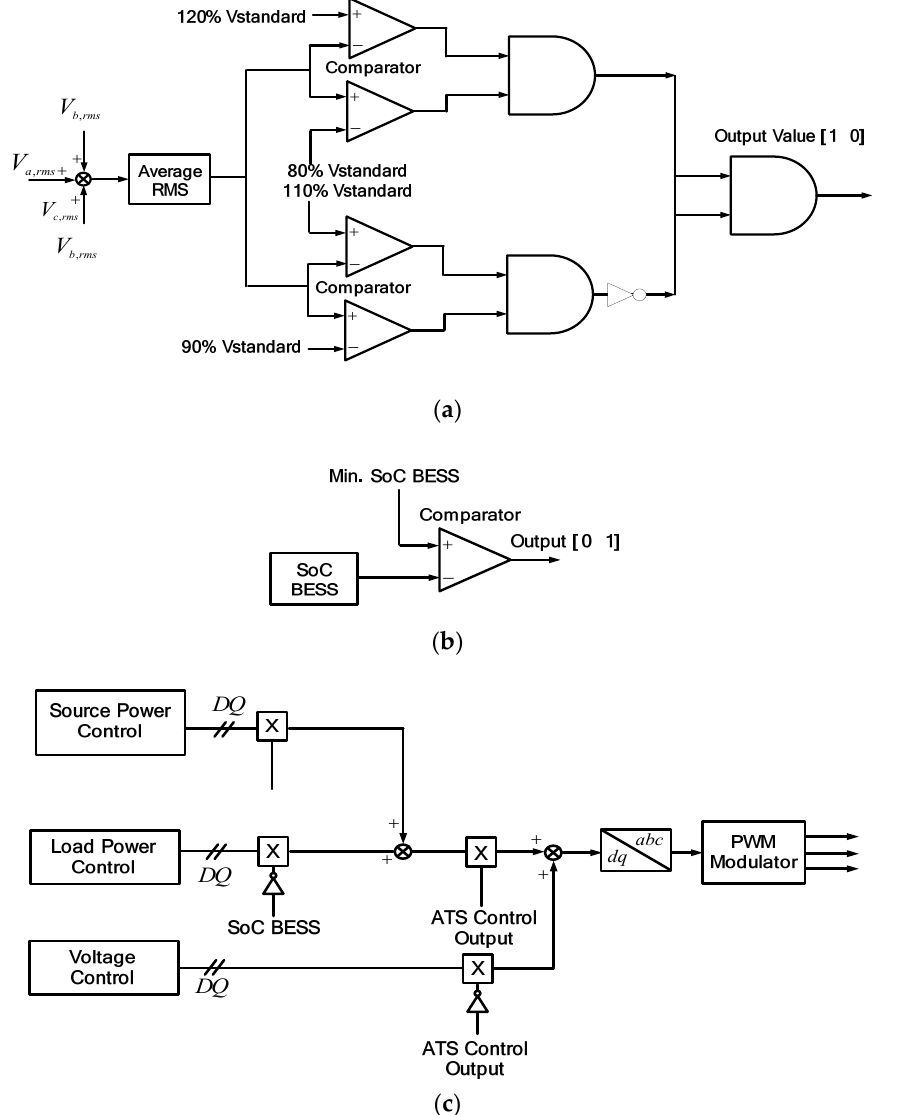
Figure 11. Automatic transfer switches: ( a ) Series inverter; ( b ) BESS; ( c ) shunt inverter.